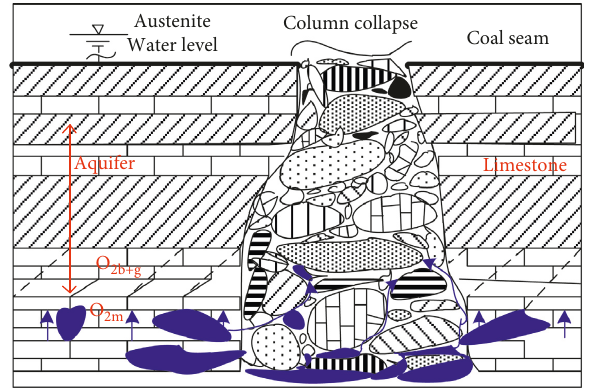
Figure 1: Schematic diagram of KCPs in the